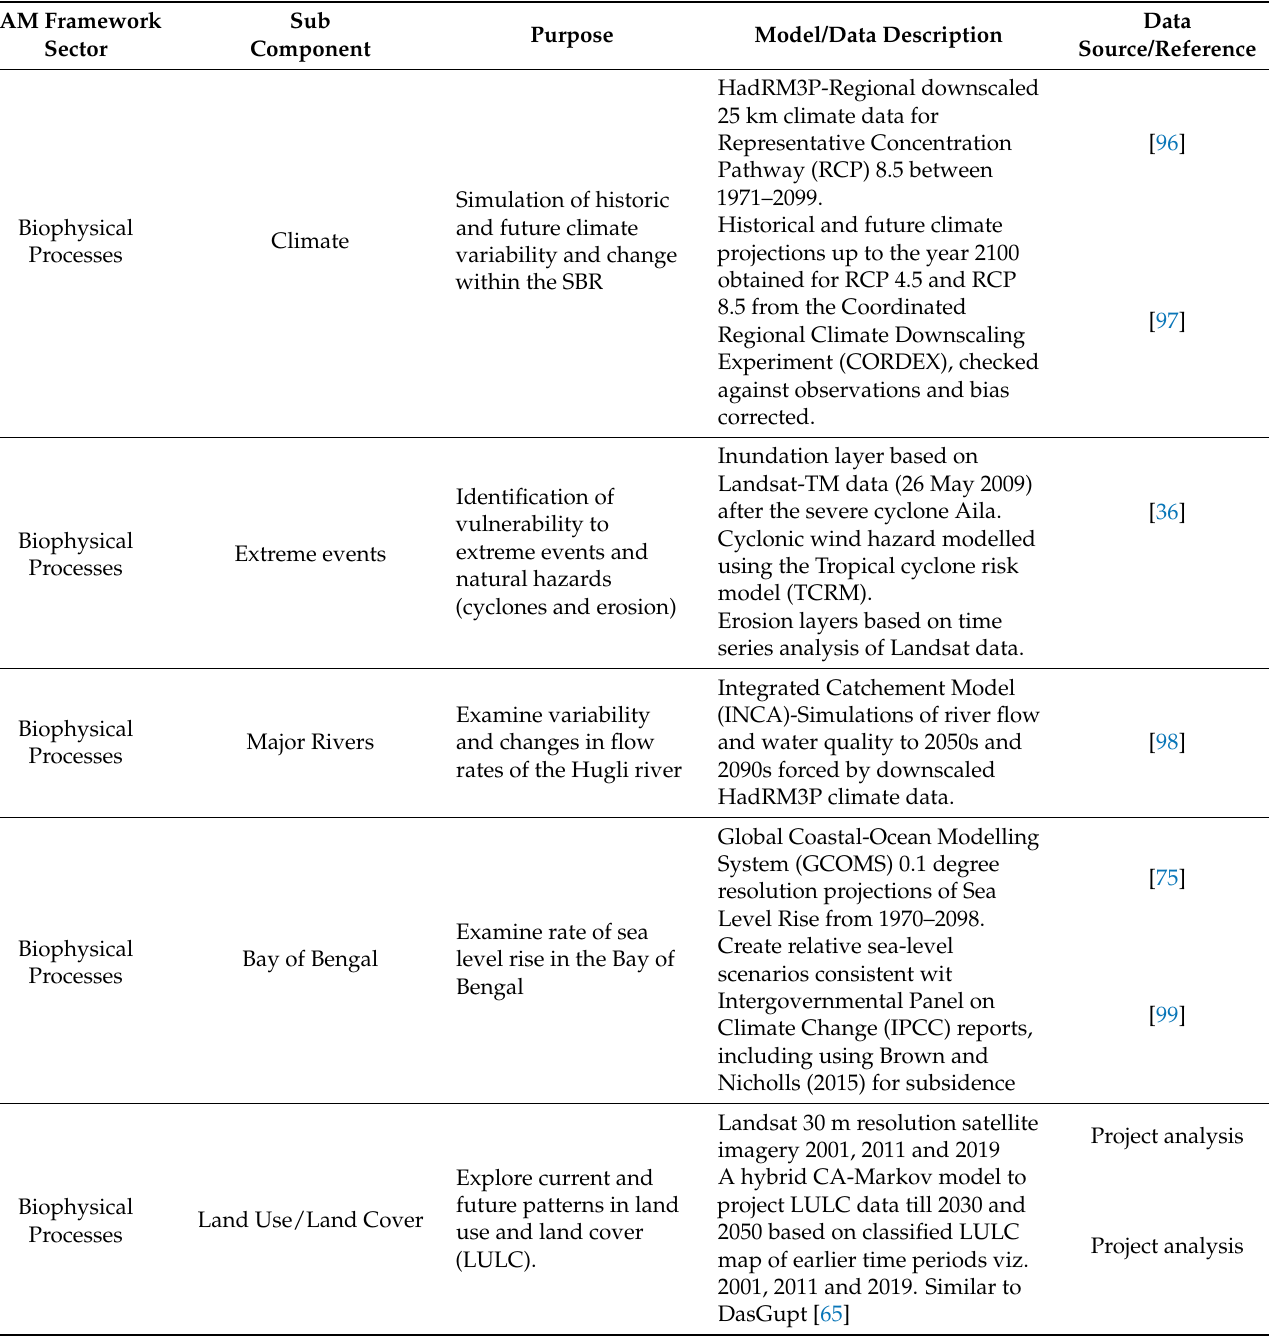
Table 3. Description of IAM framework subcomponents. References are given for data and/or model output where applicable. Where modeling and primary data collection is being completed within the scope of the project, this is indicated as ‘project analysis’ and ‘Primary data’,